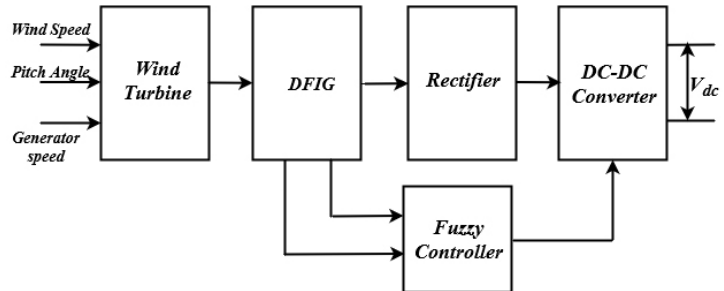
Figure 4. Control circuit of wind